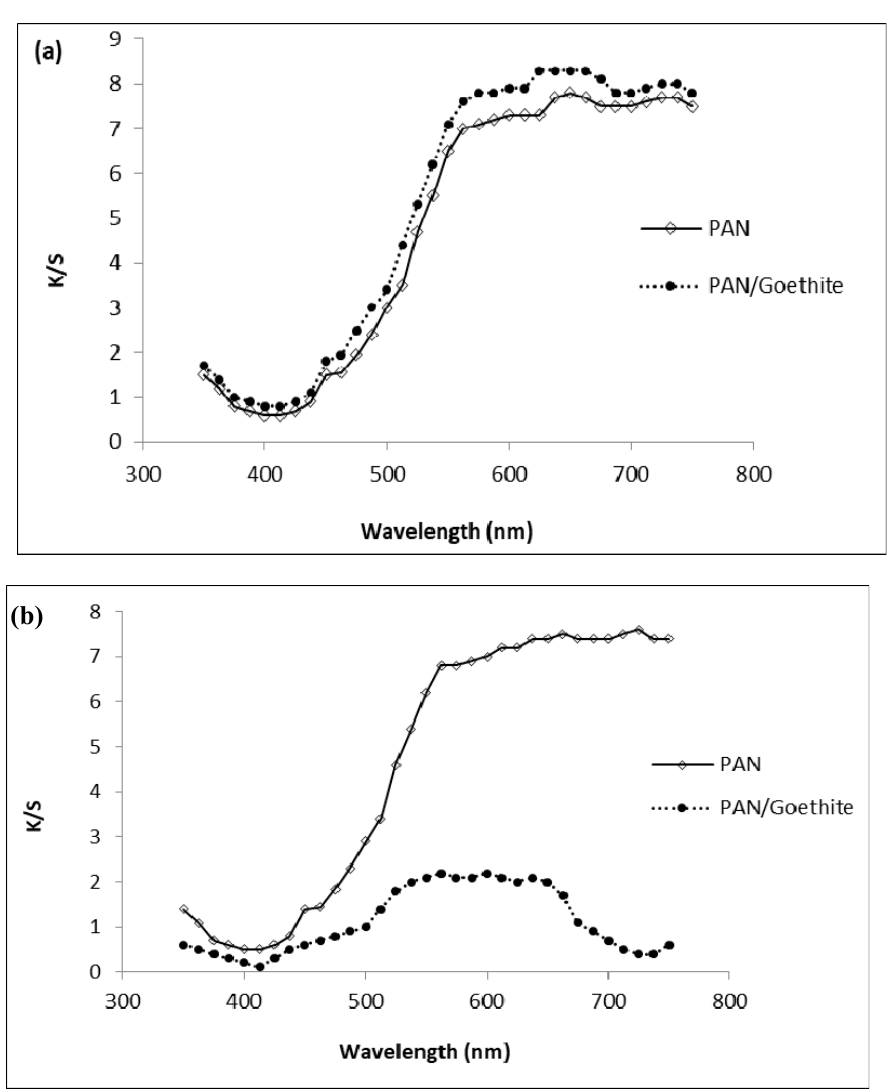
Figure 8. K/S curves of the PAN/goethite and the PAN before ( a ) and after ( b ) the photocatalytic Figure 8. K / S curves of the PAN / goethite and the PAN before ( a ) and after ( b ) the photocatalytic process.